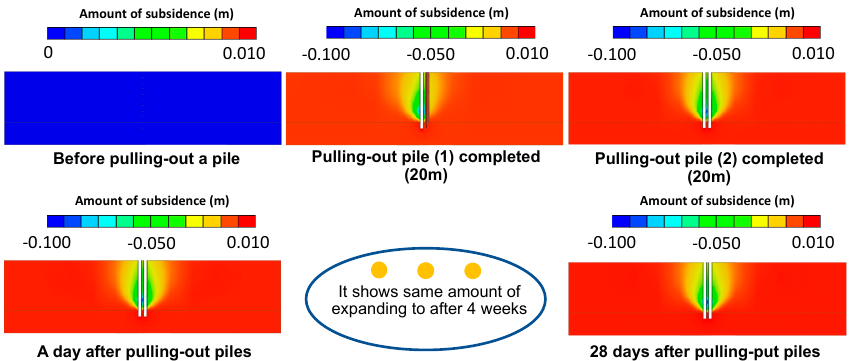
Figure 7. Deformation of surrounding ground when two extraction holes of removed piles are hol- low.